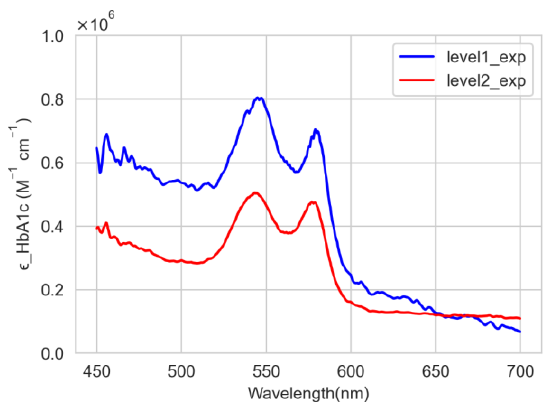
Figure 8. Experimentally calculated mean molar absorption coefficients for levels 1 and 2.